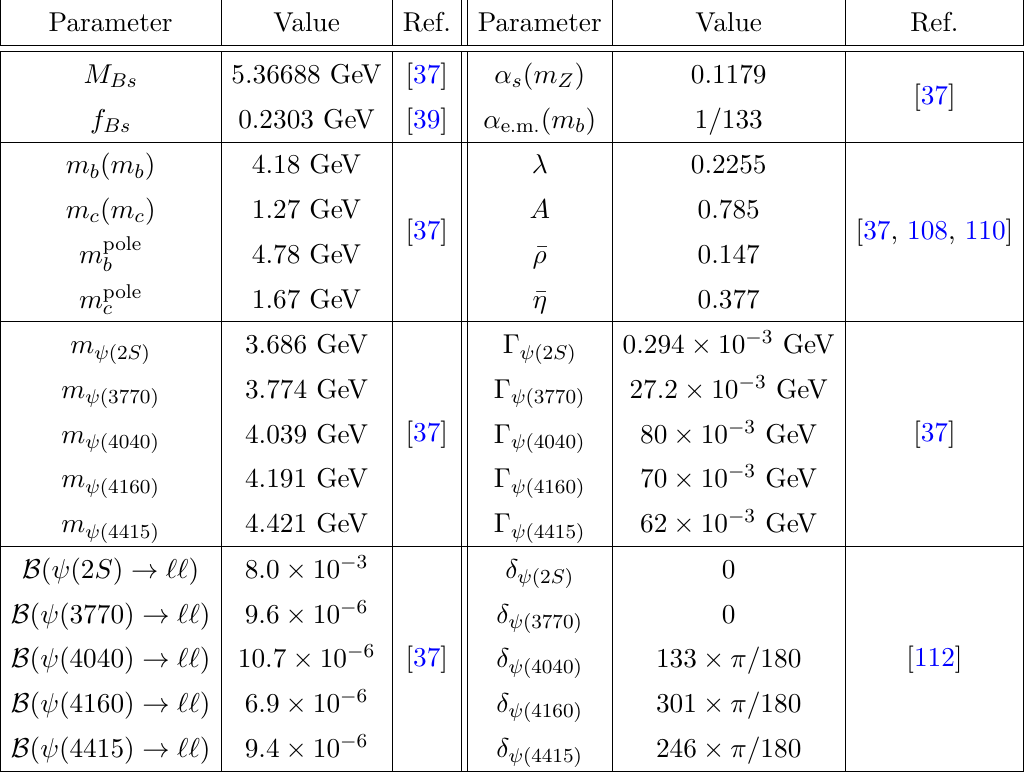
Table 3 . List of input